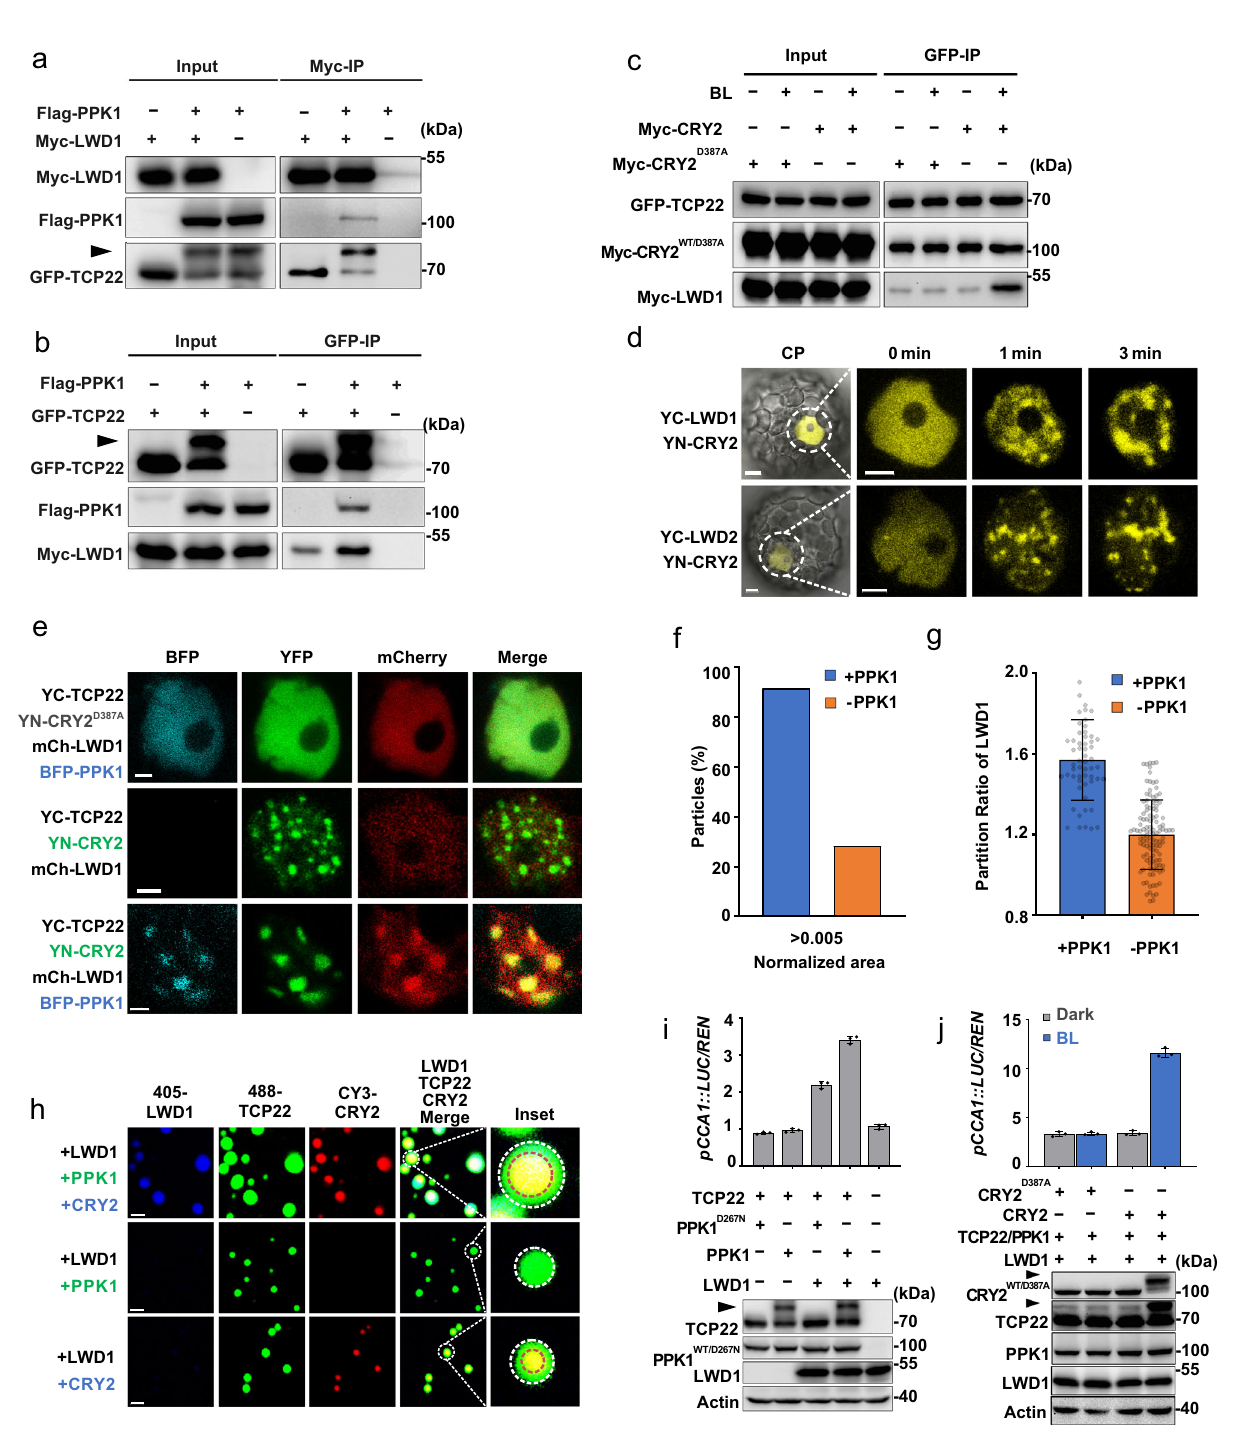
Plasmids constructs . The HEK-293T cell protein expression system was utilized. HEK-293T cell culture and transfection . HEK-293T cells (ATCC,ATCC ® CRL- Myc , Flag and GFP were inserted into pCI (neo) (Promega, E1841) using the EcoRI 11268TM) were cultured in DMEM (Biological Industries, 06-1055-57-1ACS) restriction site. The coding sequences for TCP22 , CRY2 , PPKs , and LWDs were supplemented with 10% (v/v) FBS (Biological Industries,04-001-1ACS), 100U/mL then cloned into pCI (neo) Myc, pCI (neo) Flag or pCI (neo) GFP using XbaI and penicillin, and 100mg/mL streptomycin (Hyclone,SV30010) in humidi fi ed 5% (v/v) NATURE COMMUNICATIONS| (2022) 13:2631